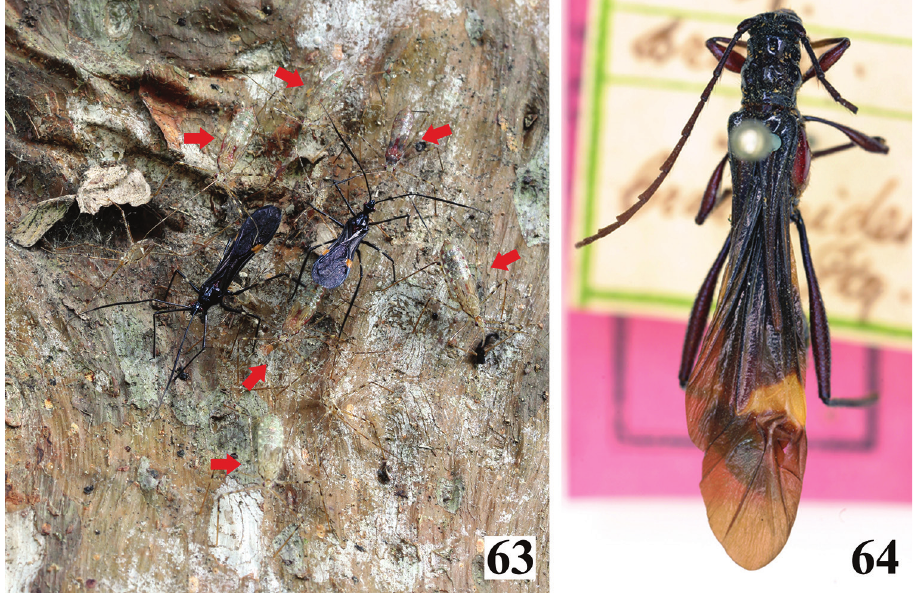
tree trunk; red arrows point to nymphs 64 female holotype of Isthmiade braconides (Perty, 1832) (Coleop- tera: Cerambycidae: Cerambycinae: Rhinotragini), deposited in the ZSM, Munich, Germany (courtesy of Steve